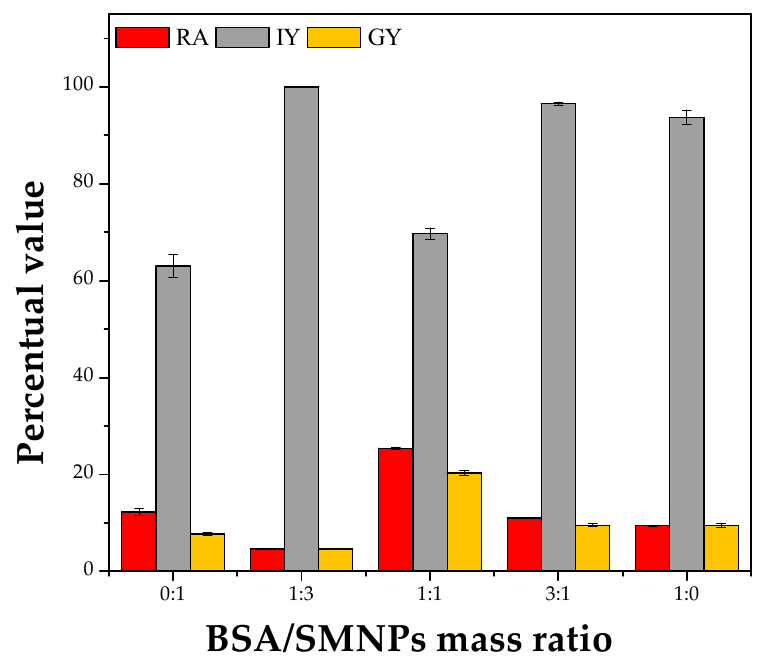
Figure 2. Effect of the BSA/SMNPs mass ratio on the immobilization parameters (RA—recovered activity, IY—immobilization yield, and GY—global yield) of porcine pancreas lipase (PPL) as CLEAs. Assay conditions: precipitation with ethanol (enzyme solution/ethanol volume ratio of 1:3), co-aggregation with additives (enzyme/total additives mass ratio of 1:3), crosslinking with glutaraldehyde (5 μ moles of glutaraldehyde/mg total protein), temperature of 4 °C, 30 min precipitation/aggregation and 2.5 h crosslinking under 150 rpm stirring.